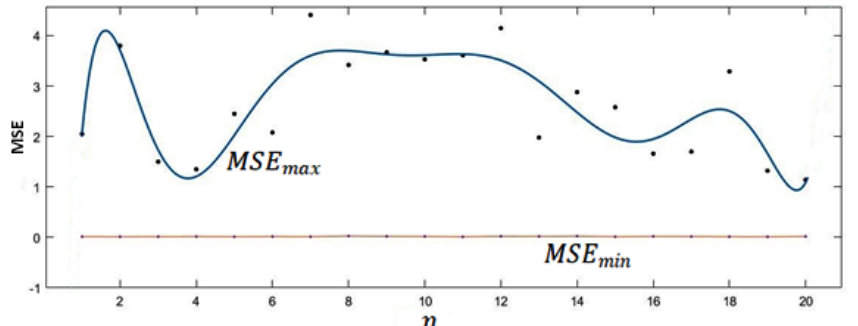
Figure 5. Minimum and maximum mean squared error (MSE) ( 𝑀𝑆𝐸 𝑚𝑖𝑛 and 𝑀𝑆𝐸 𝑚𝑎𝑥 ) versus the number of considered time-delayed data samples involved in the prediction task ( 𝑛 ).